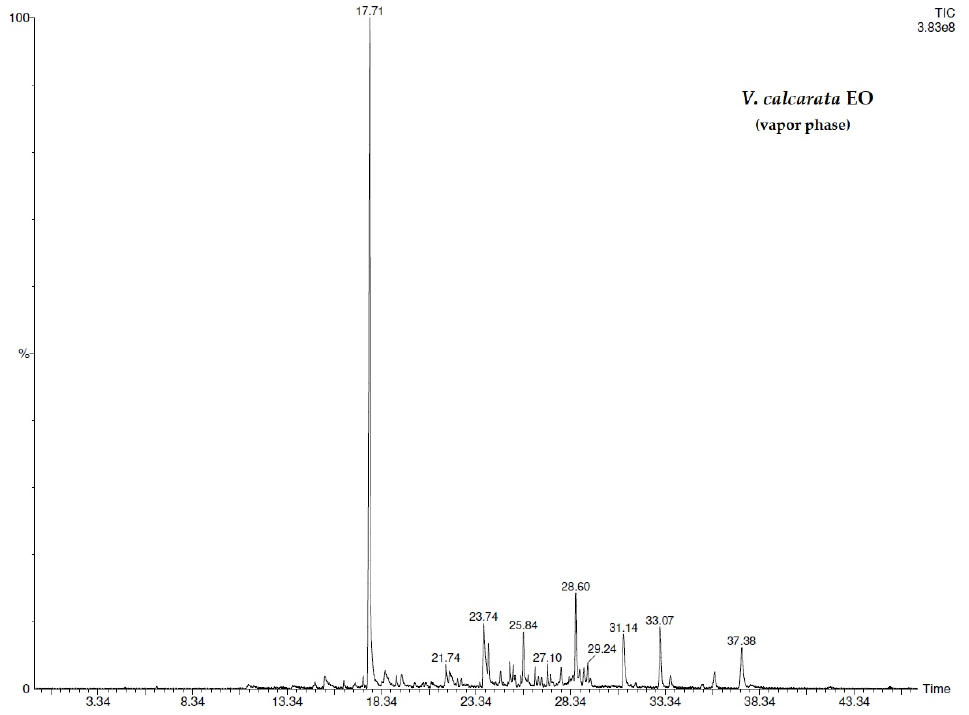
Figure 2. SPME/GC-FID chromatograms of V. calcarata EO.